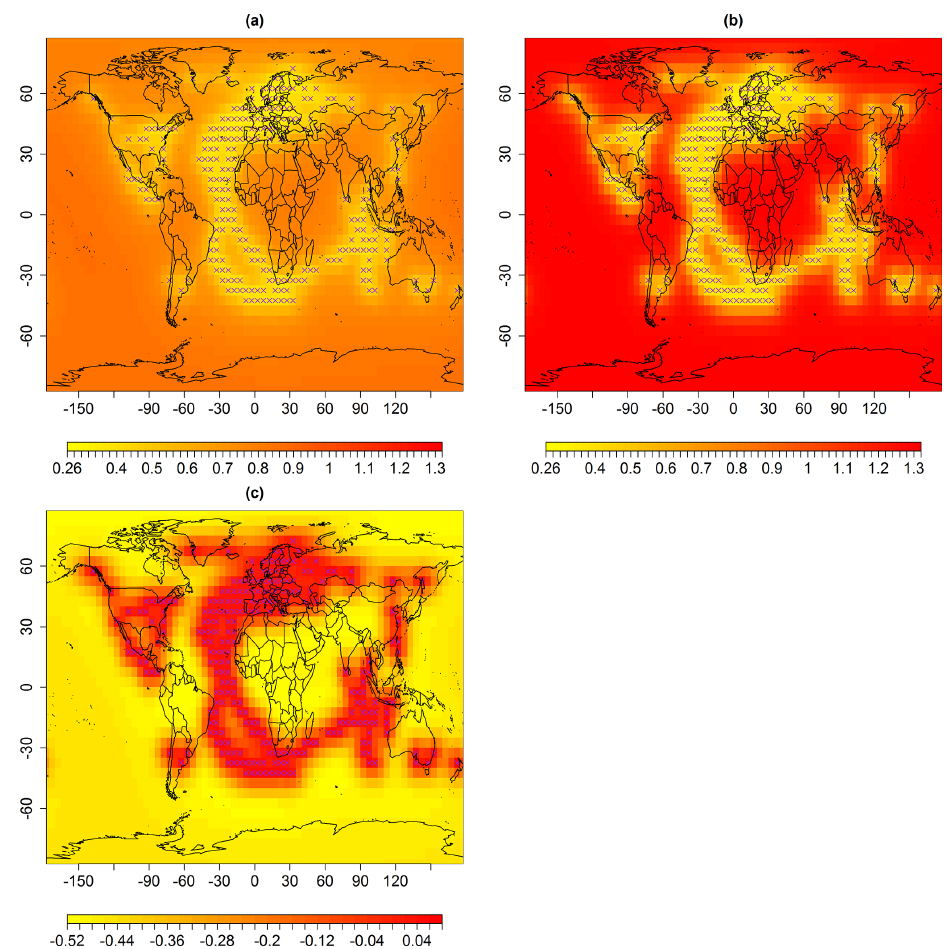
Figure 4. Standard error (uncertainties) in degrees Celsius associated with spatial predictions for median May 1861, using multi-resolution lattice kriging based on (a) ABC, using a variogram (Sect. 2.1), and (b) the profile maximum likelihood approach (Nychka et al., 2015) used to create data in Ilyas et al. (2017). (c) The difference in panels (a) and (b) , i.e., panels (a) – (b) . The × signs show observed spatial sites